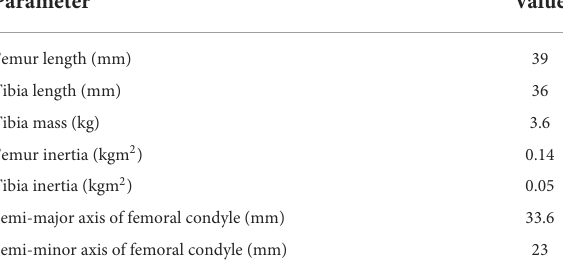
TABLE 3 Physical parameters of the lower limb in the